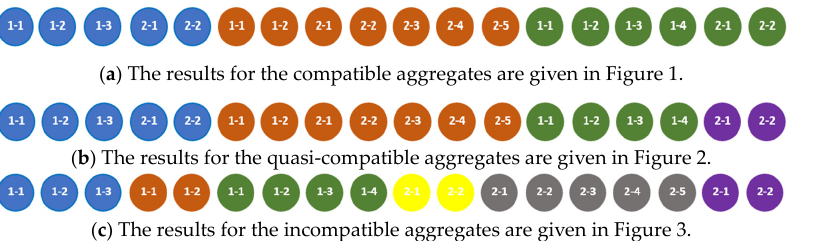
Figure 5. An example of applying the union operation to two aggregates of di ff erent compatibility.